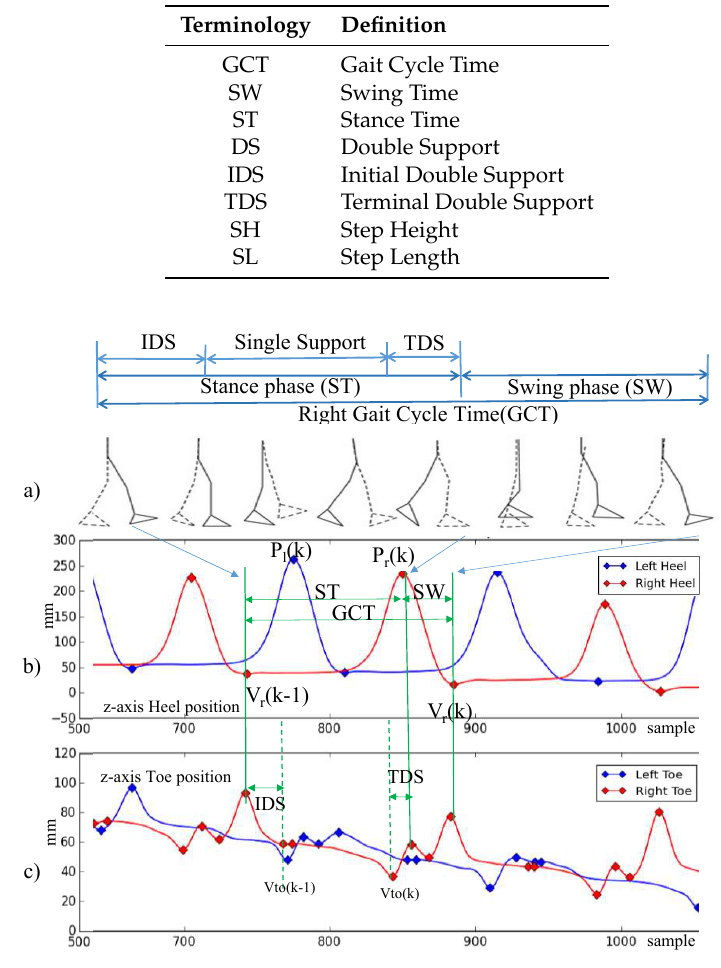
Figure 3. Gait cycle model. ( a ) Gait cycle model ( b ) z-axis heel position ( c ) z-axis toe